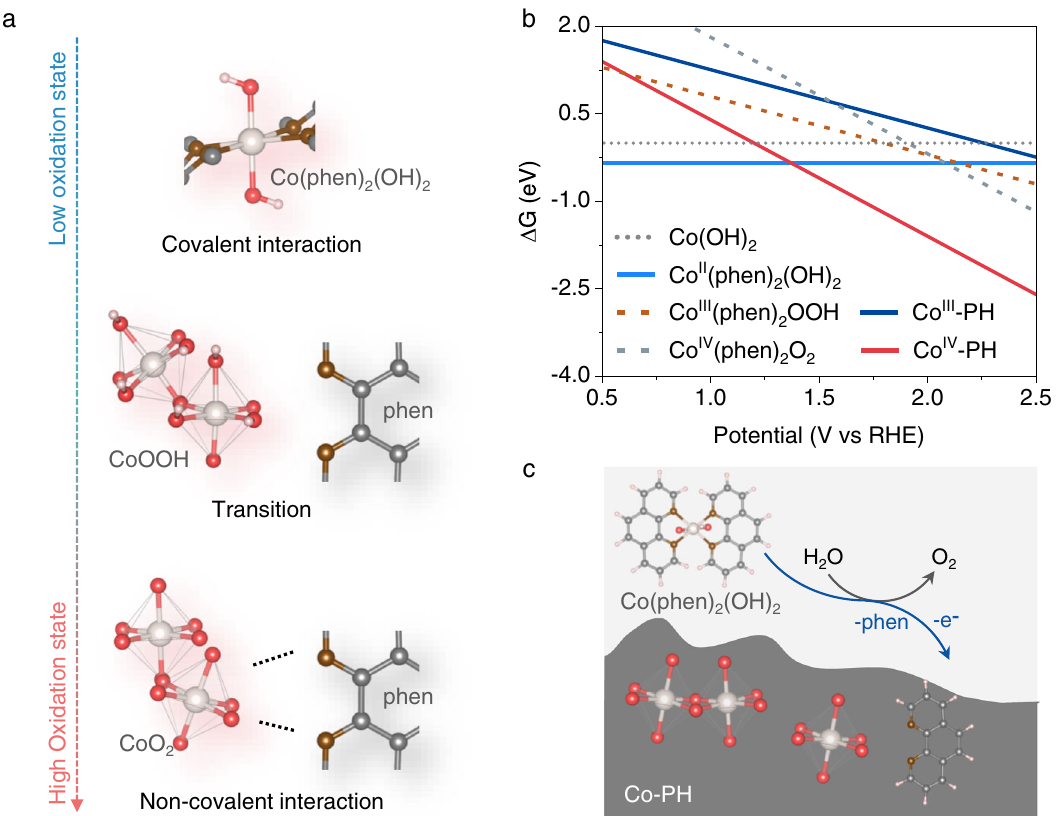
Fig. 4 | Valence-dependent interactions betweenCo and phen. a The scheme of valence-dependentinteractionsbetweenCoandphen. b Thefreeenergydiagrams of Co(OH) 2 , Co II (phen) 2 (OH) 2 , Co III (phen) 2 OOH, Co IV (phen) 2 O 2 , phen-inserted CoOOH (Co III -PH), and phen-inserted CoO 2 (Co IV -PH). c The scheme for the